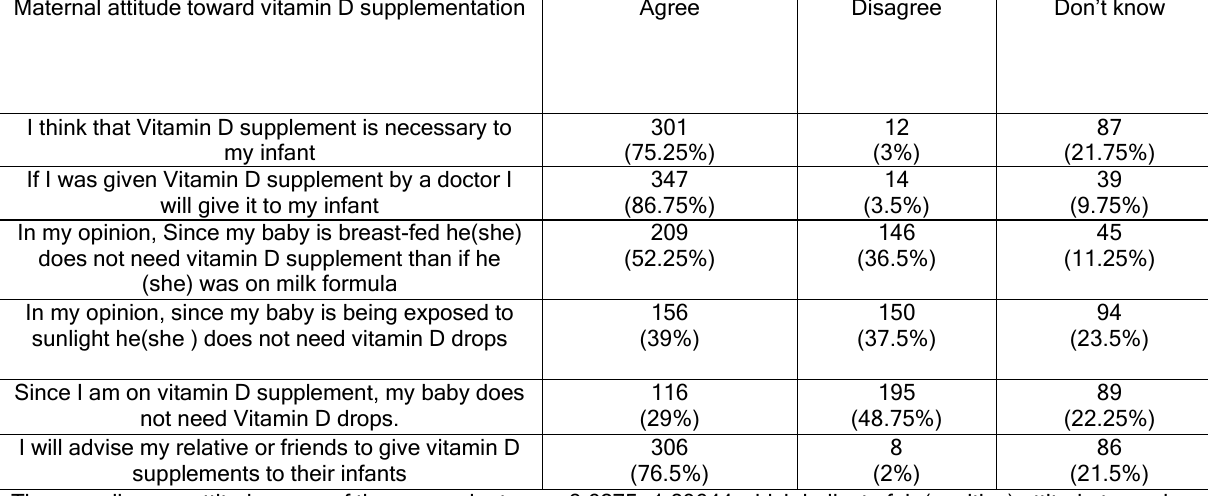
Table 4: Participant’s responses in attitude towards Vitamin D supplementations Maternal attitude toward vitamin D supplementation